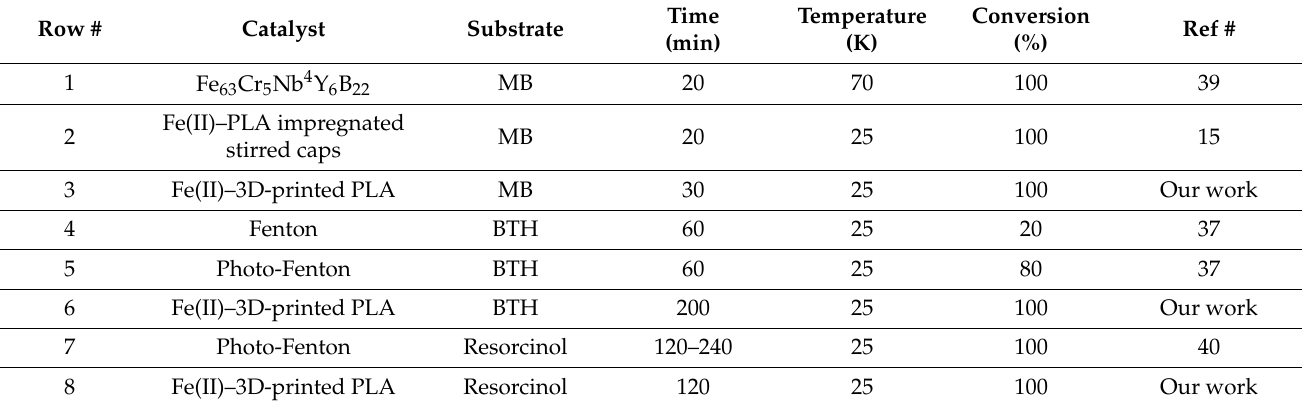
Table 2. Comparison of the efficiency of the 3D PLA catalyst with different results in the literature.